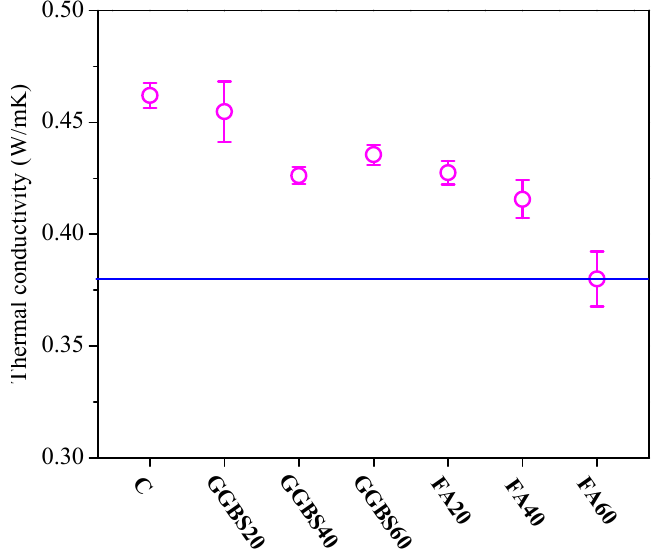
Figure 12. Thermal conductivity of the seven ULHS-ECCs in the current study.